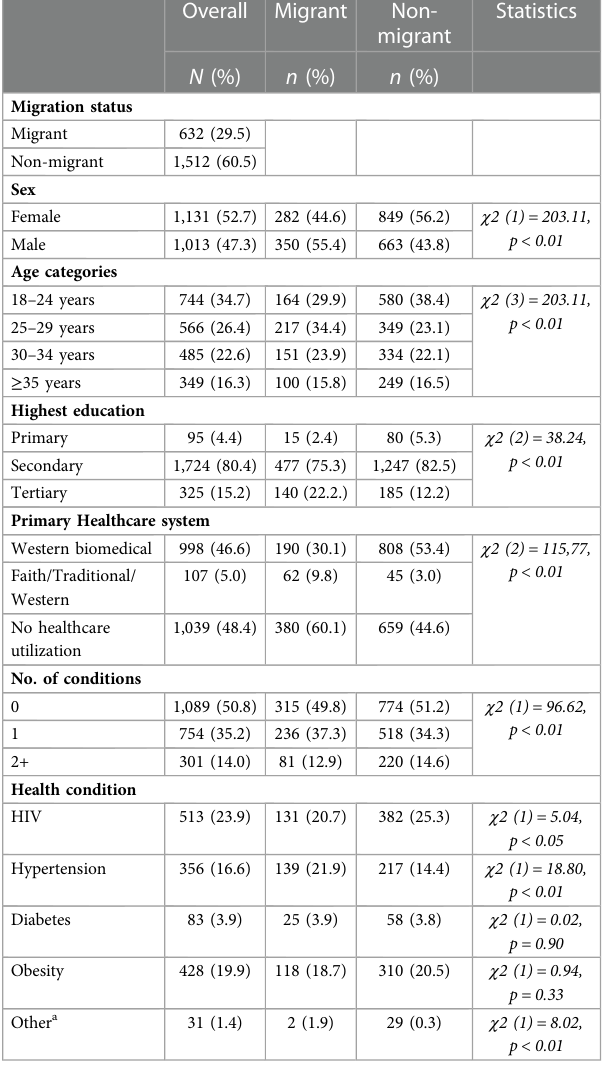
Table 4 highlights further results based on interaction effects.